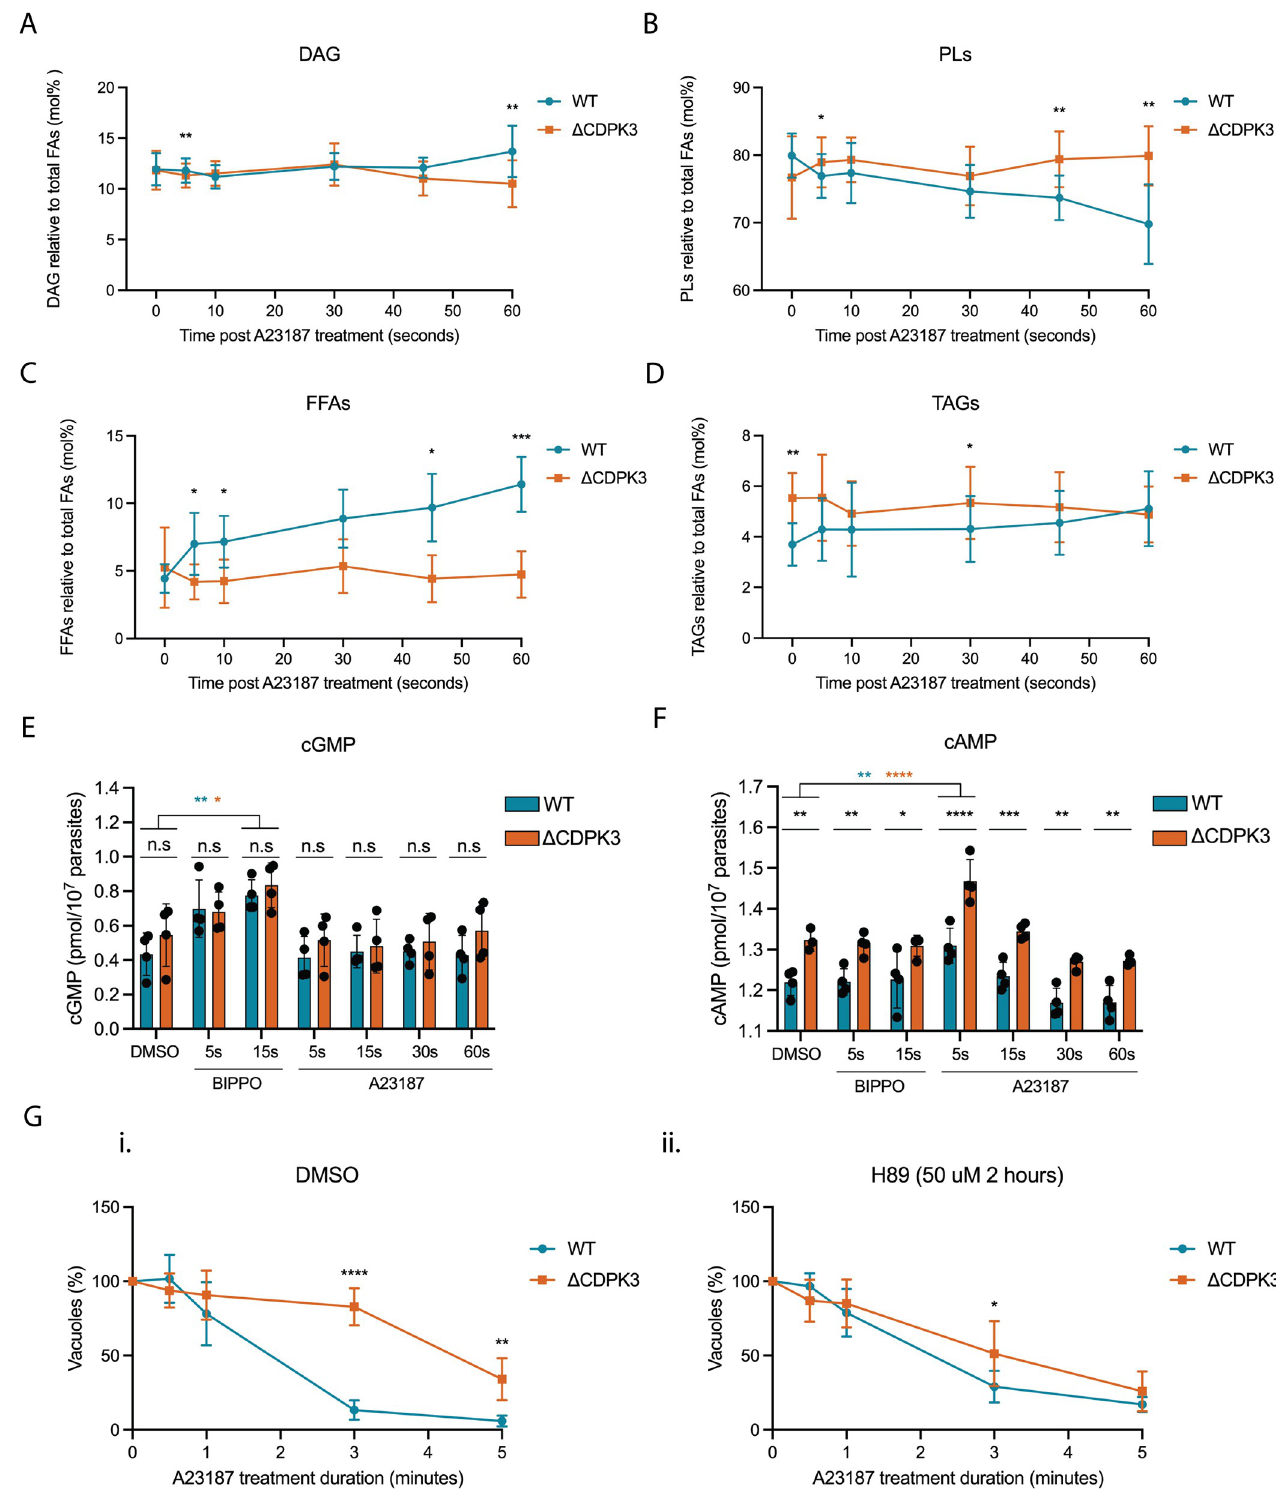
Fig 4. Disruption of CDPK3 leads to perturbations in lipid and cAMP signalling following A23187 treatment Pulse experiment of WT and Δ CDPK3 parasites treated with DMSO (0s) or 8 μ M A23187 for 5, 10, 30, 45 or 60 seconds analysing levels of (A) DAG, (B) PLs, (C) FFAs and (D) TAGs, with data expressed as %mol relative to total FAs. Data are represented as mean ± s.d. (n = 4). Significance between WT and Δ CDPK3 parasites was assessed using a paired two sample t-test. ��� , P � 0.001; �� , P � 0.01; � , P � 0.05. (E) Comparison of intracellular cGMP and (F) cAMP levels in WT and Δ CDPK3 tachyzoites